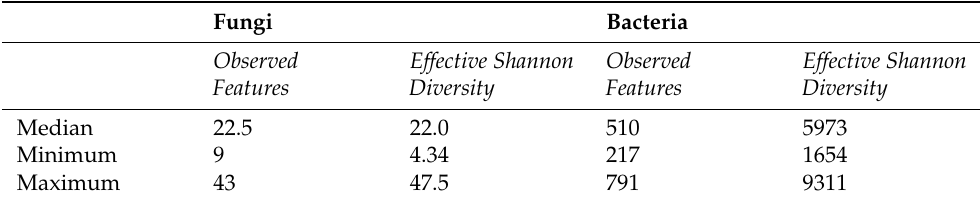
Table 2. Alpha-Diversity of fungal and bacterial communities in the adaptation period. Fungi Bacteria